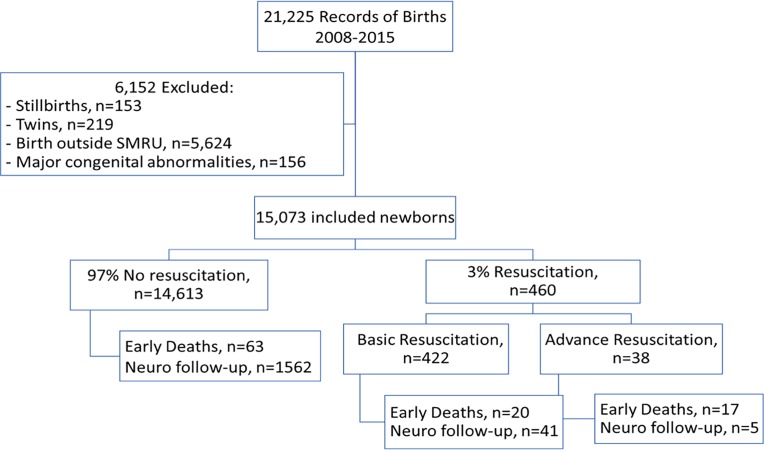
Flowchart of the study.